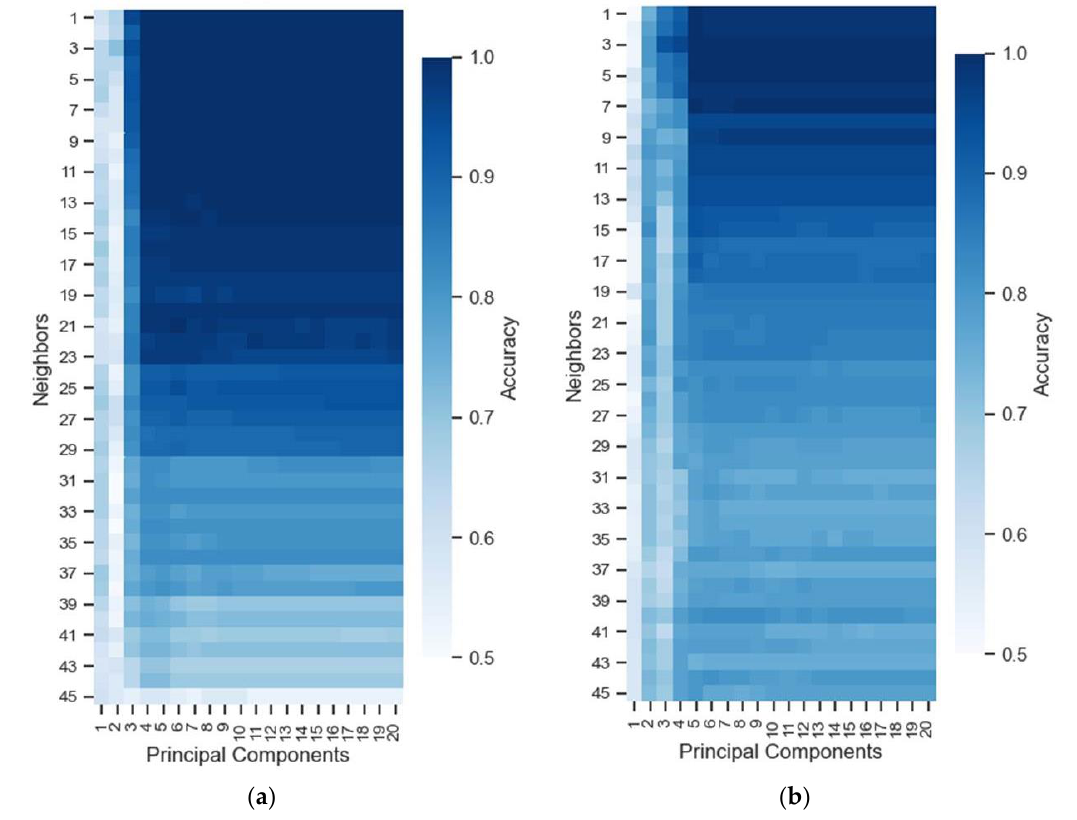
Figure 3. Heat map representing the accuracy values obtained in the extensive search optimizing the PC and Near Neighbors parameters in the ( a ) UV and ( b ) VIS region. PC and Near Neighbors parameters in the ( a ) UV and ( b ) VIS region.